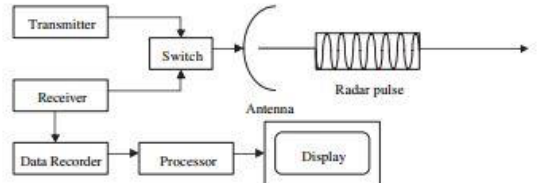
Figure 1. Basic block diagram of typical radar system (Chan, Y.K., Koo, V.C., 2008.)